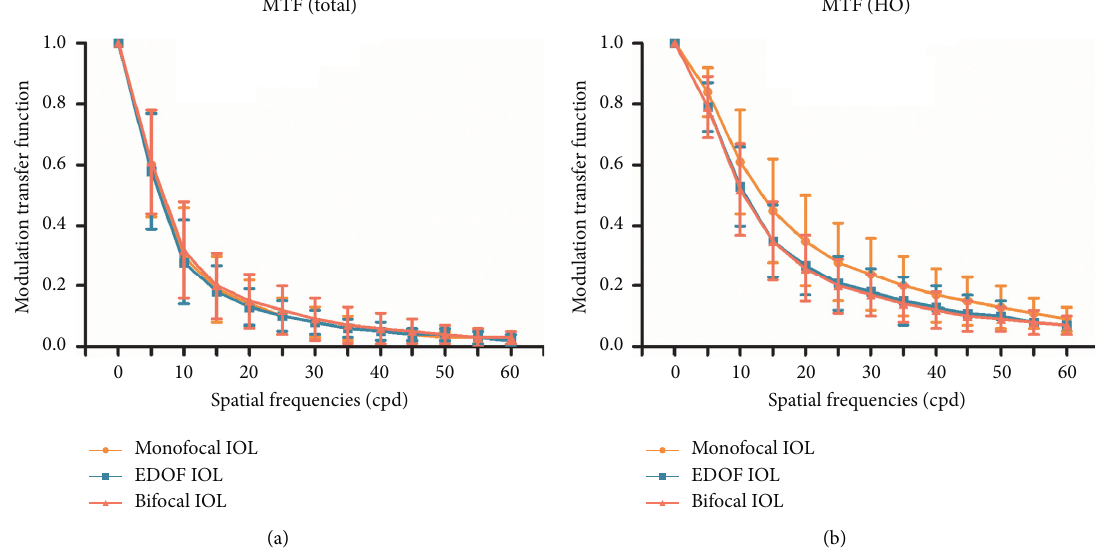
Figure 3: Comparison of the mean total (ocular) modulation transfer function (MTF) values (a) and mean MTF (HO) values (b) among the 3 intraocular lens (IOL) groups at different spatial frequencies. No significant difference was observed among the 3 IOL groups for any of the spatial frequencies. Error bars represent the standard deviation (SD) of the mean (total: indicates data calculated from total aberrations; HO: data calculated from only high-order aberrations; EDOF � extended range of